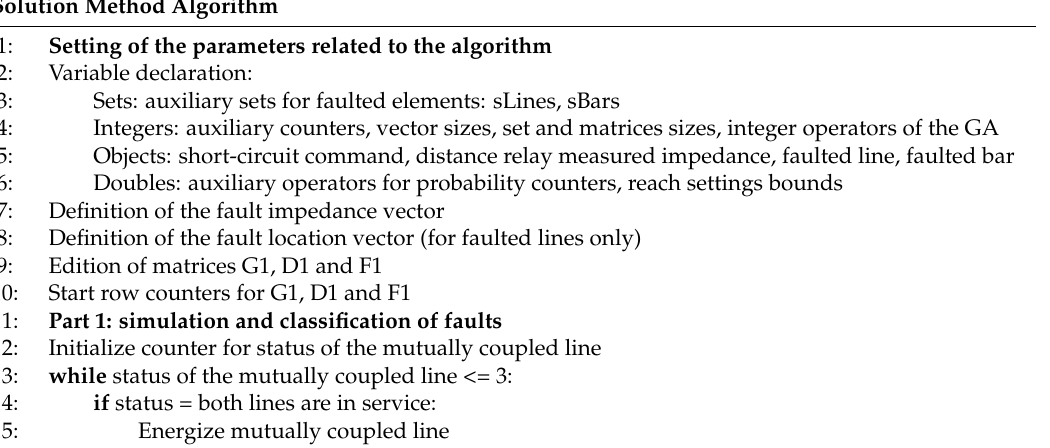
Table A1. Detailed pseudocode for the solution method algorithm. Solution Method